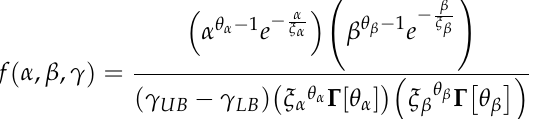
, respectively. The scale parameters of 𝛼 and 𝛽 are denoted as 𝜃 (cid:3080) and